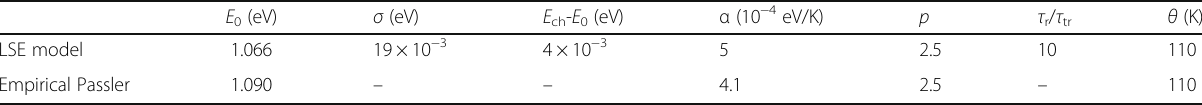
Table 2 Parameters used to fit the energy evolution using empirical Passler (a) and modified Passler (b) model